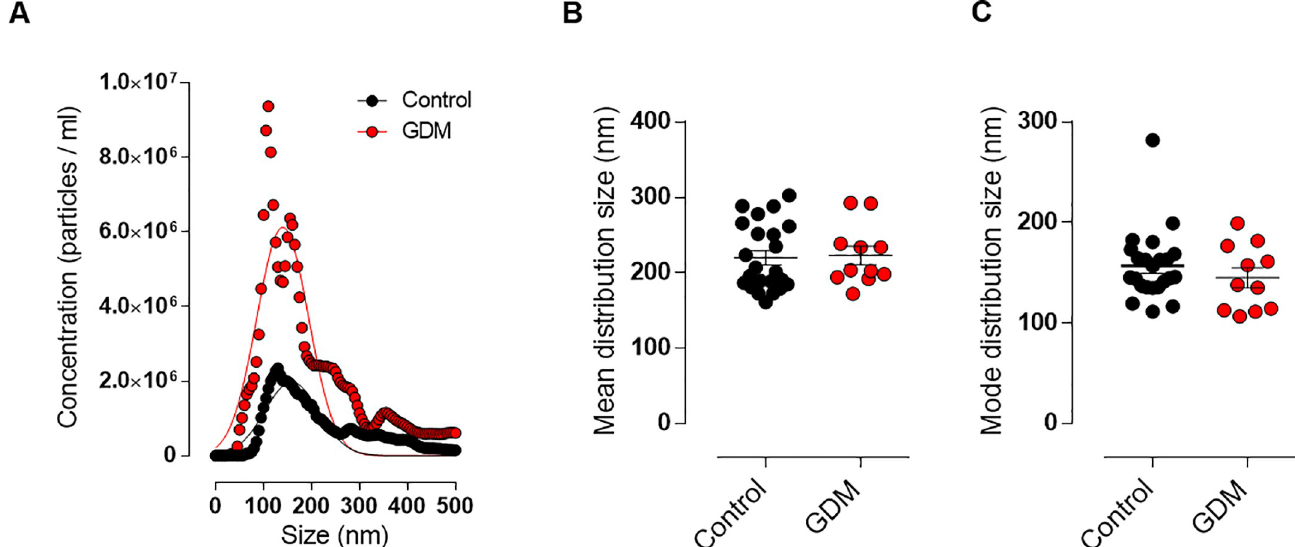
Fig 2. Nanoparticle tracking analysis of EVs isolated from GFC using ExoQuick in controls and patients with GDM. A. Distribution size of EVs isolated from GCF with higher concentration of nanoparticles in the GDM group (red dots) in comparison with the control group (black dots). B. Mean and C. Mode distribution size of total extracellular vesicles isolated from Controls (n = 23) and GDM (n = 11) pregnant women. GDM, gestational diabetes mellitus.